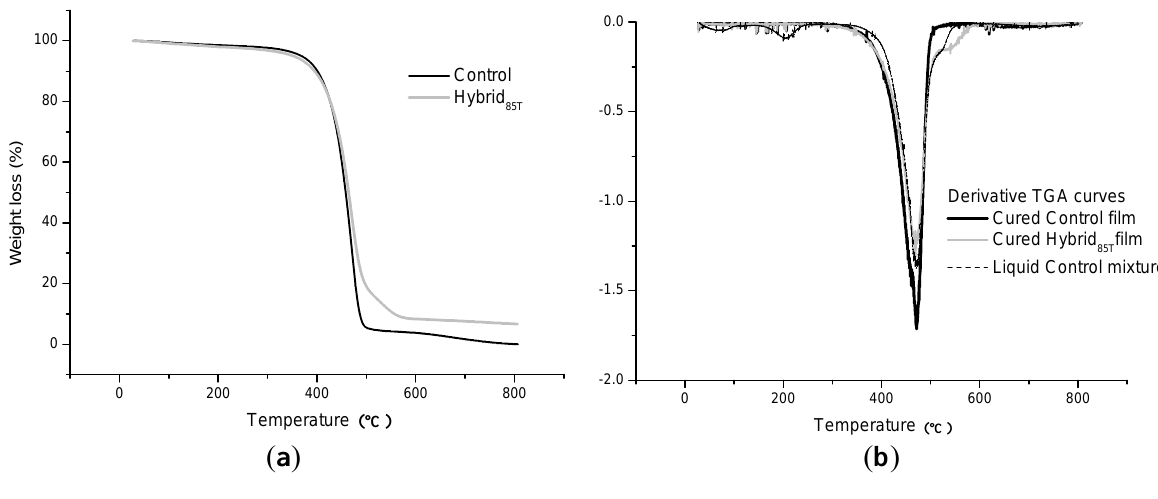
Figure 8. ( a ) TGA curves of dual-cured Ctrl Silane and Hybrid ( b ) derivative TGA curves of dual-cured Ctrl Silane and Hybrid